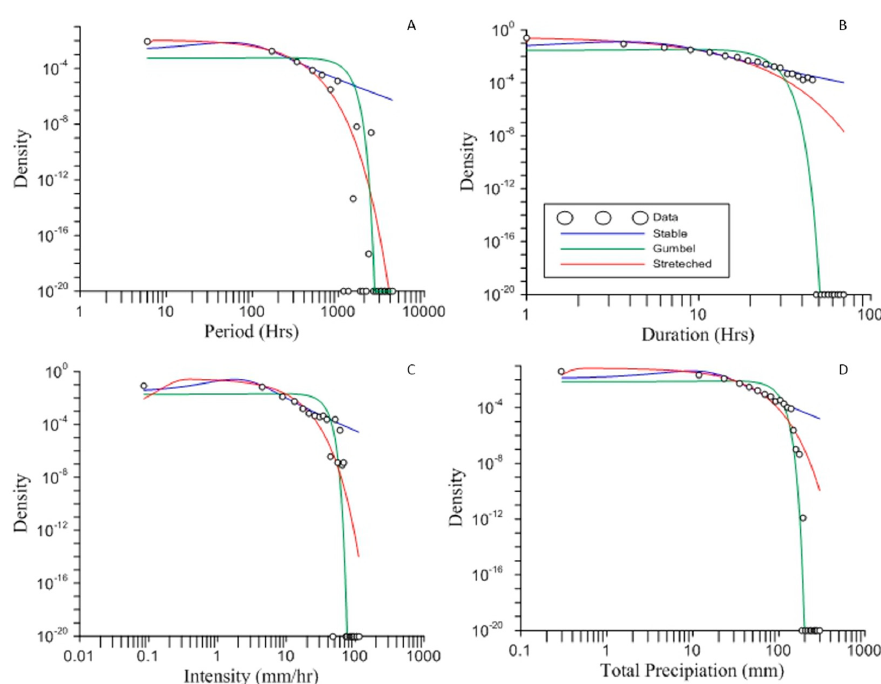
Figure 7. The best-fit PDF distribution for the full data set of each storm property: Inter-storm periods ( A ), duration ( B ), intensity ( C ), and total precipitation ( D ) using the three proposed distributions: Stable (the blue line), Gumbel (green line), and stretched Gaussian (red line) compared to the actual data (open circles).